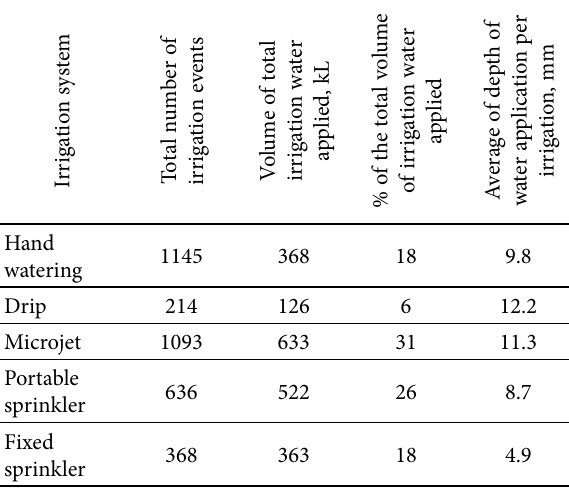
Table 3. Variation of water application with different irrigation systems during the trial period